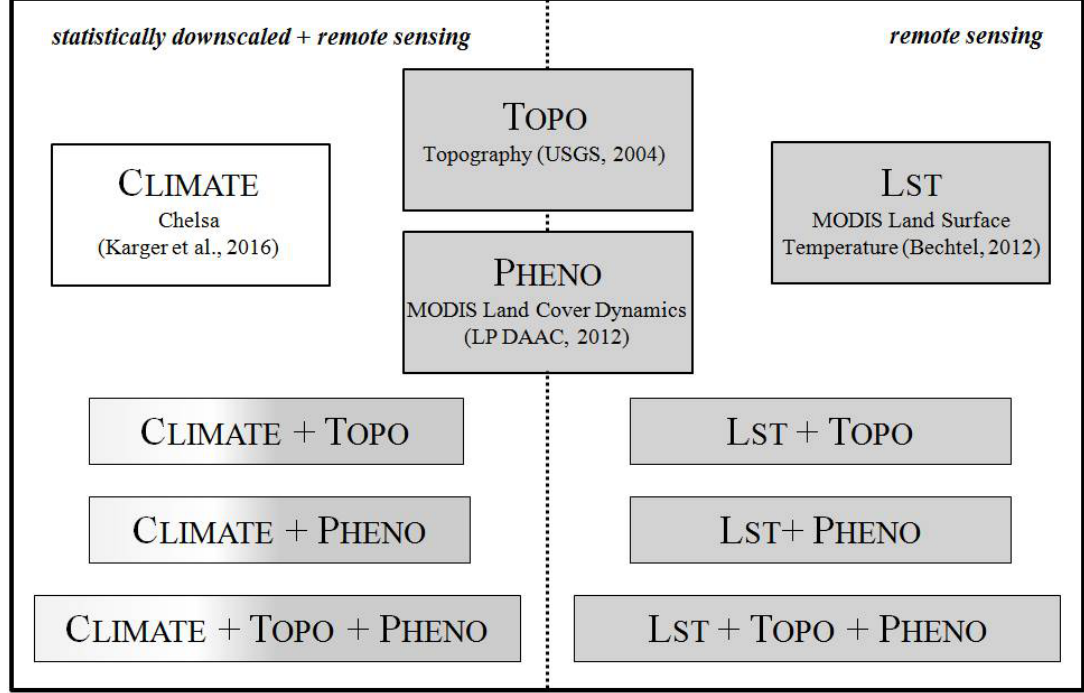
Figure 2. Overview of the predictor sets used in the modelling procedure for estimating the ecological niche of Betula utilis .